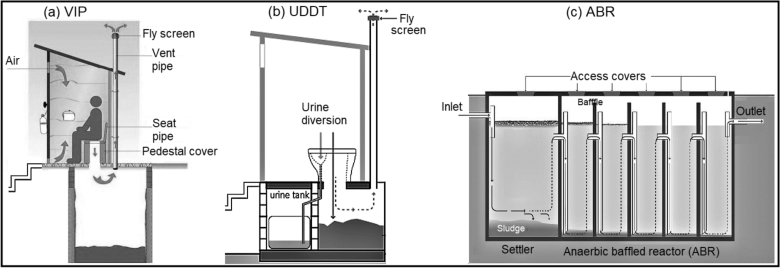
Illustrations of, (a) Ventilated Improved Pit (VIP) latrine, (b) Urine Diversion Dry Toilet (UDDT) (Strande and Brdjanovic, 2014), and (c) Anaerobic Baffled Reactors (ABR) (Tilley, 2014).